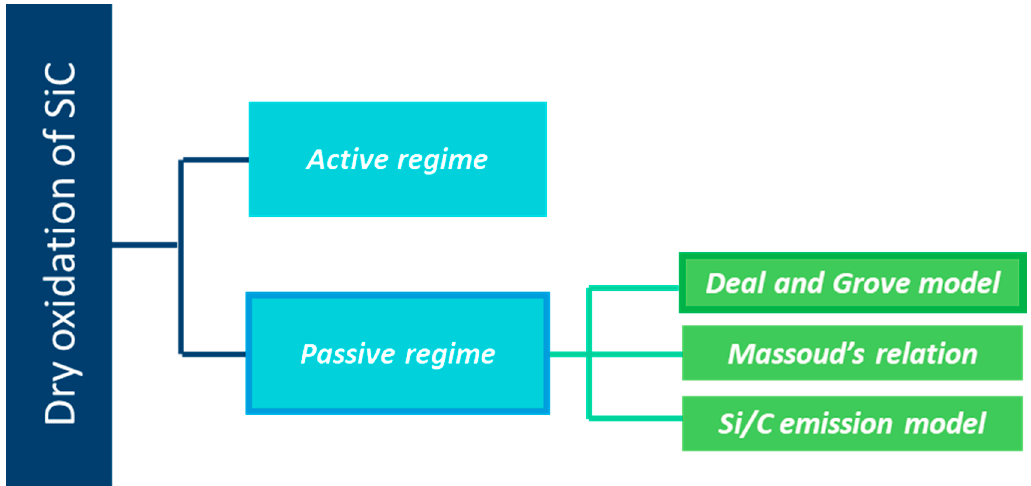
Figure 1. Layout of the dry oxidation of SiC part.